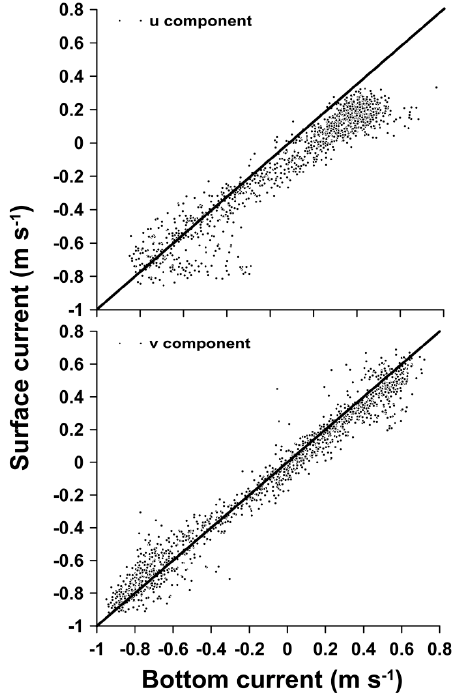
Figure 2. Near surface and bottom (2 m above seabed) currents measured by recording Doppler current profiler (RDCP) off Dahej at 12 m water depth from 18 to 28 March 2016. profiler (RDCP) o ff Dahej at 12 m water depth from 18 to 28 March Equations (1)–(3) are solved using the Alternate Direction Implicit (ADI) scheme, which is a